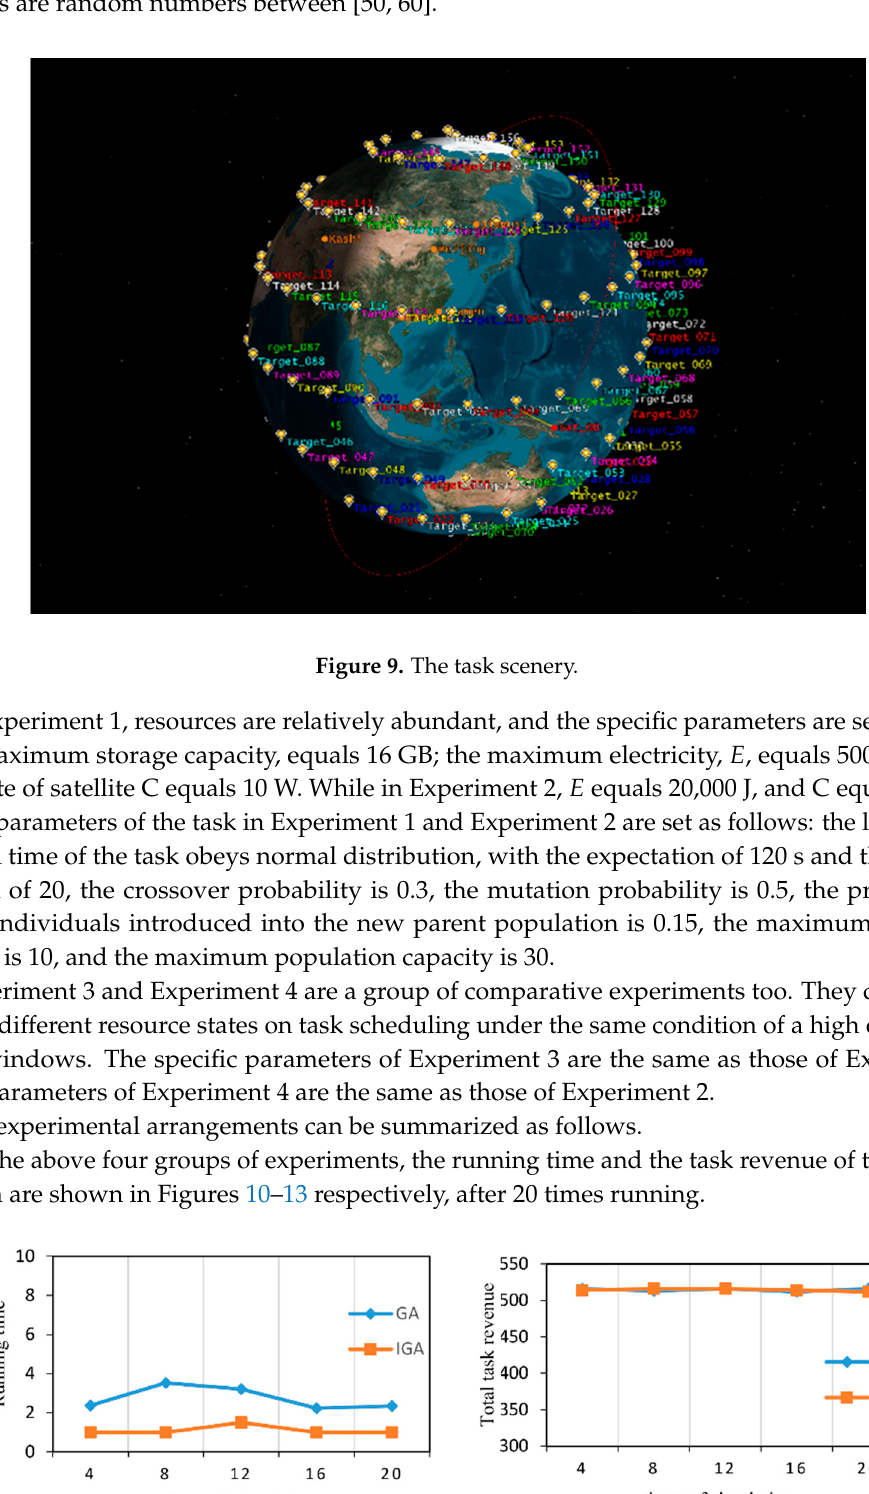
12 of 18 Table 2. Ground Station Parameters. Ground Station